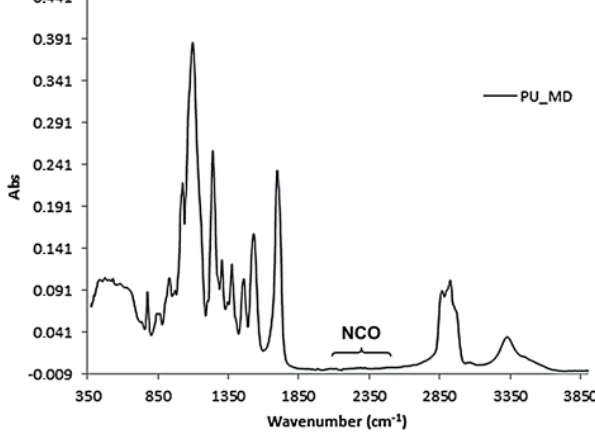
Figure 4. IR spectrum of PU_MD .